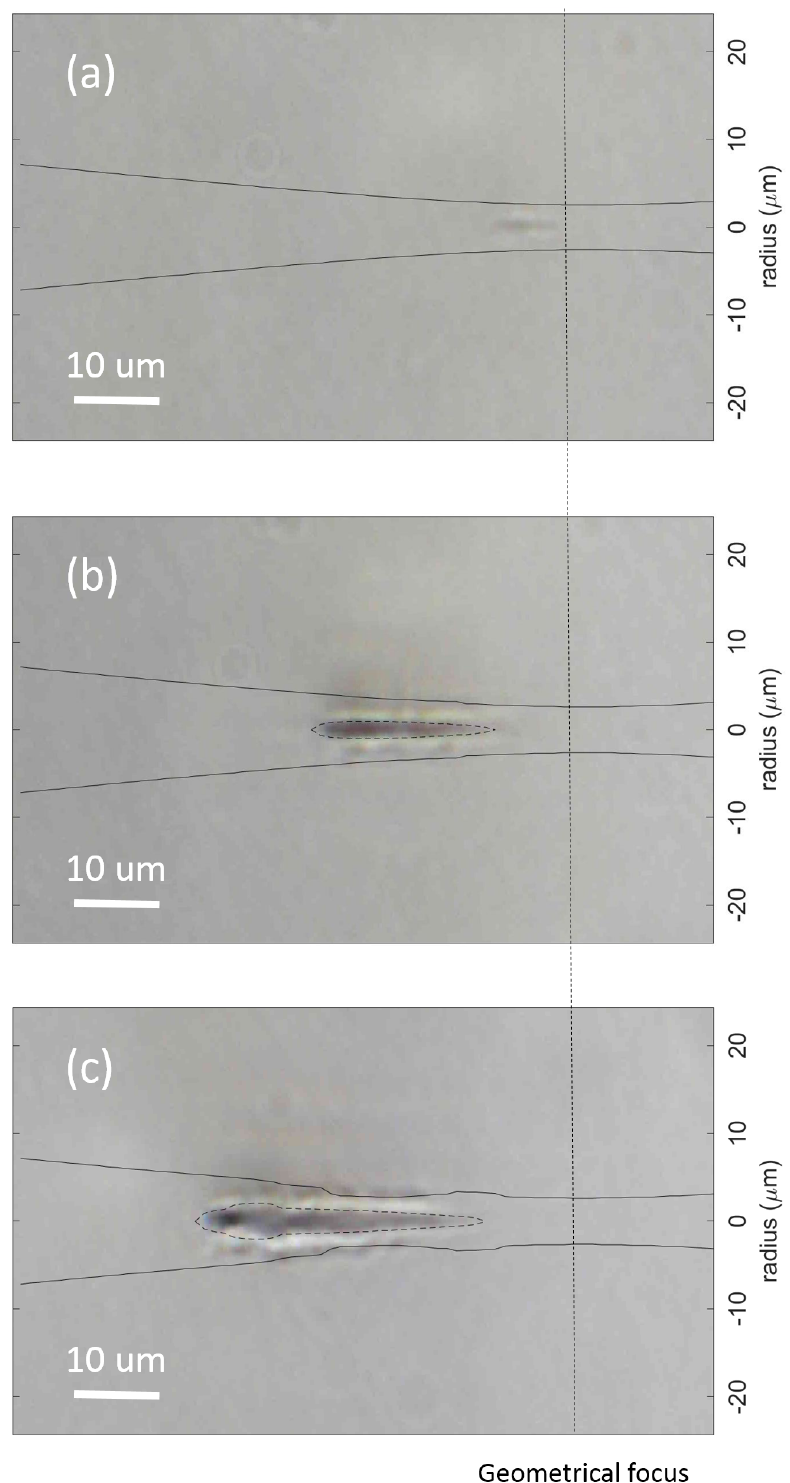
Figure 4. Simulation results of beam propagation and electron density overlaid on the experimental results. The input pulse energy are ( a ) 1 µJ, ( b ) 3 µJ, ( c ) 5 µJ. The solid line indicates the beam radius at 1/ e 2 intensity level. The dashed contour indicates the max electron density at the level of ρ max = 10 20 cm − 3 , and the vertical dashed line indicates the position of the geometrical focus. The relative role of electron contribution from multiphoton ionization and avalanche ionization is shown in Figure 5. The maximum electron density clamps at around 10 20 cm −